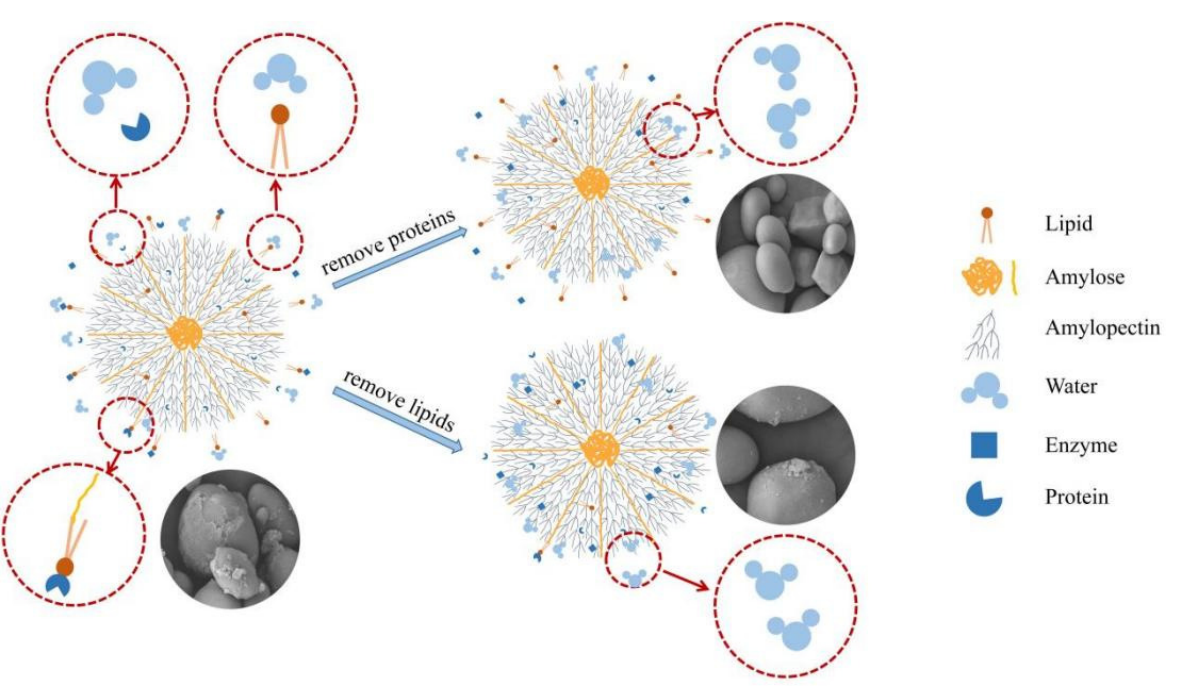
Figure 4. Schematic diagram of removing proteins and lipids from starch granule. Table 3. Thermal and digestive properties of AF and after removal of non-starch nutrients. Sample